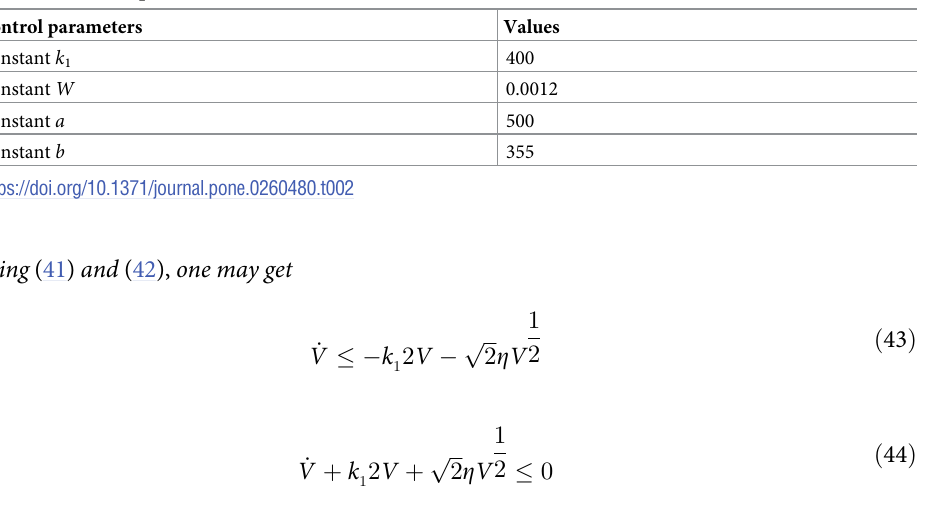
Table 2. Controller parameters.